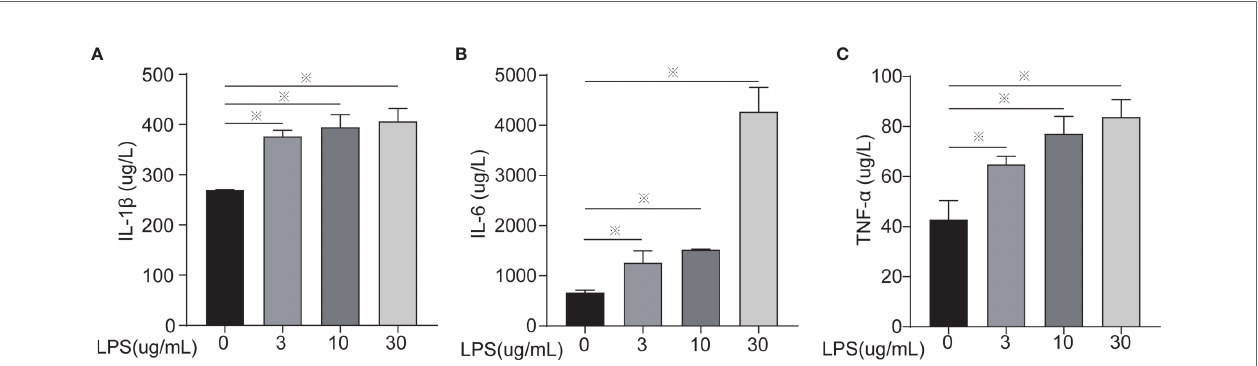
FIGURE 1 | In fl ammatory cytokines content of cells treated with different concentrations of LPS for 24 h. (A) IL-1 b , (B) IL-6, and (C) TNF- a . Each treatment had three samples (n = 3) and was repeated three times to reduce system errors; “ ※ ” means there was a signi fi cant difference ( P < 0.05 ) compared with negative control (LPS, 0